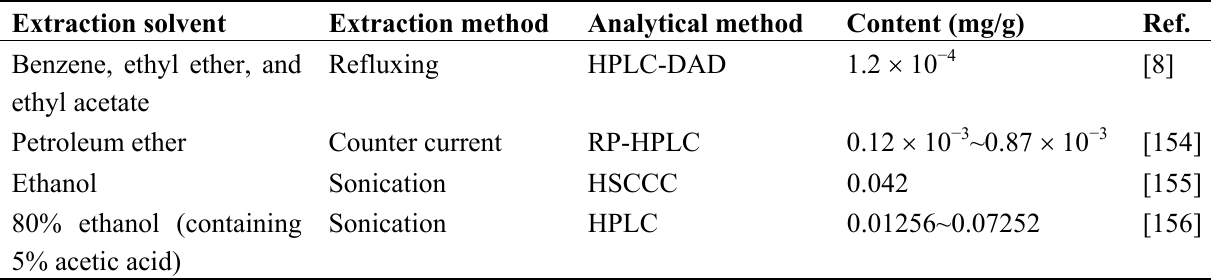
Table 4. The concentration variation of TMP ( 67 ) in CX analyzed by different